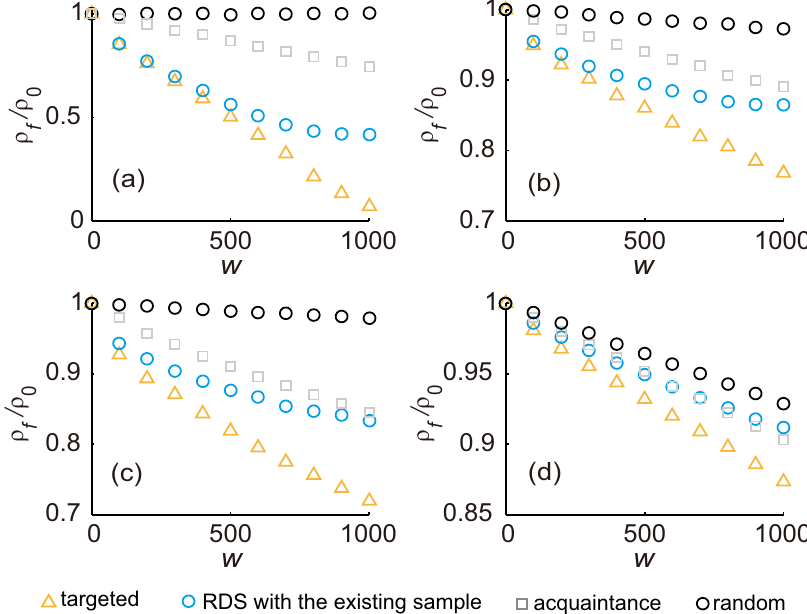
Figure 6. Reduced prevalence ρ f / ρ 0 from simulations of the SIS model in ( a ) the Advogato network, ( b ) the Brightkite network, ( c ) the Epinions network network and ( d ) the MSM network with random strategy, acquaintance strategy, targeted strategy and practical RDS strategy, i.e., immunization within the existing sample, at a fixed spreading rate λ = 0.25. The prevalence is averaged over 100